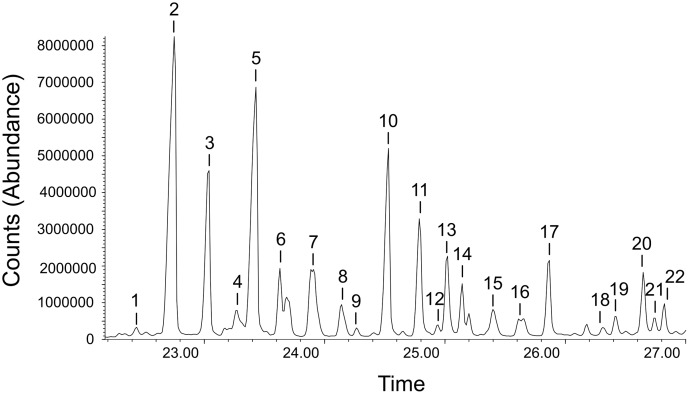
Example of a Gas chromatography-Mass spectrography (GS-MS) chromatogram of hydrocarbon molecules in C. scutellaris.The x-axis is the time (in minutes) elapsed from injection of the compound mixture to the elution of chemicals (retention time). The y-axis represents absolute abundance, which is related to the number of times each ion reported in the chromatogram struck the GS-MS detector. Chemical compounds are 1) c27_1, 2) c27, 3) M11c27, 4) DM11yc27, 5) M3c27, 6) c28, 7) CeMc28, 8) M2c28, 9) c29_1, 10) c29, 11) CeMc29, 12) M5c29, 13) DM11yc29, 14) M3c29, 15) c30, 16) CeMc30, 17) M4c30, 18) c31, 19) CeMc31, 20) DM11yc31, 21) DM7yc31, 22) DM5yc31. Compounds abbreviations: M: methyl; CeM: central-methyl; DM: dimethyl.